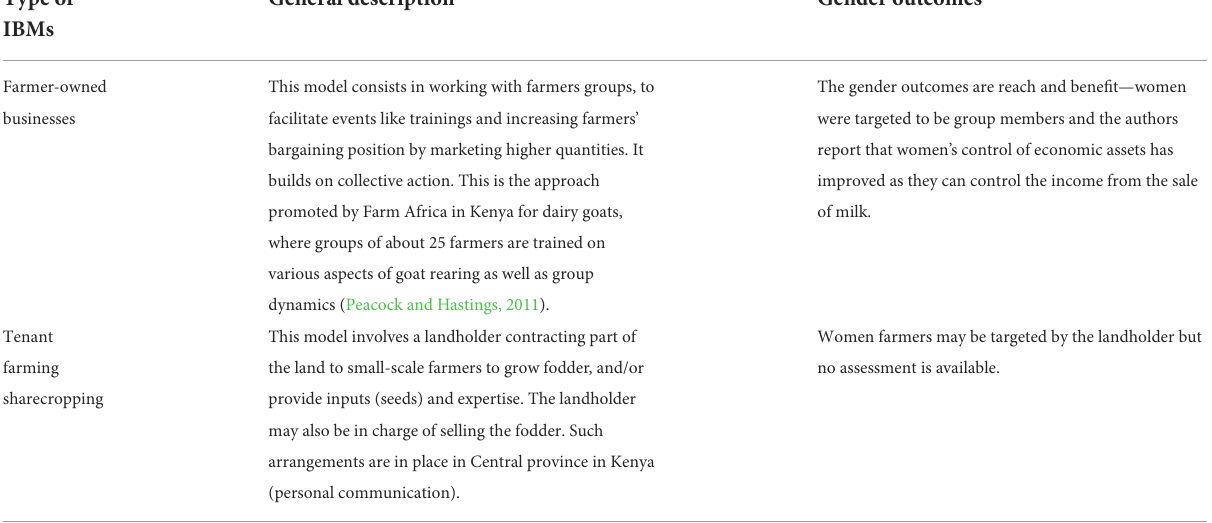
TABLE 1B Examples of producers-driven gender-inclusive business models, and reported gender outcomes.